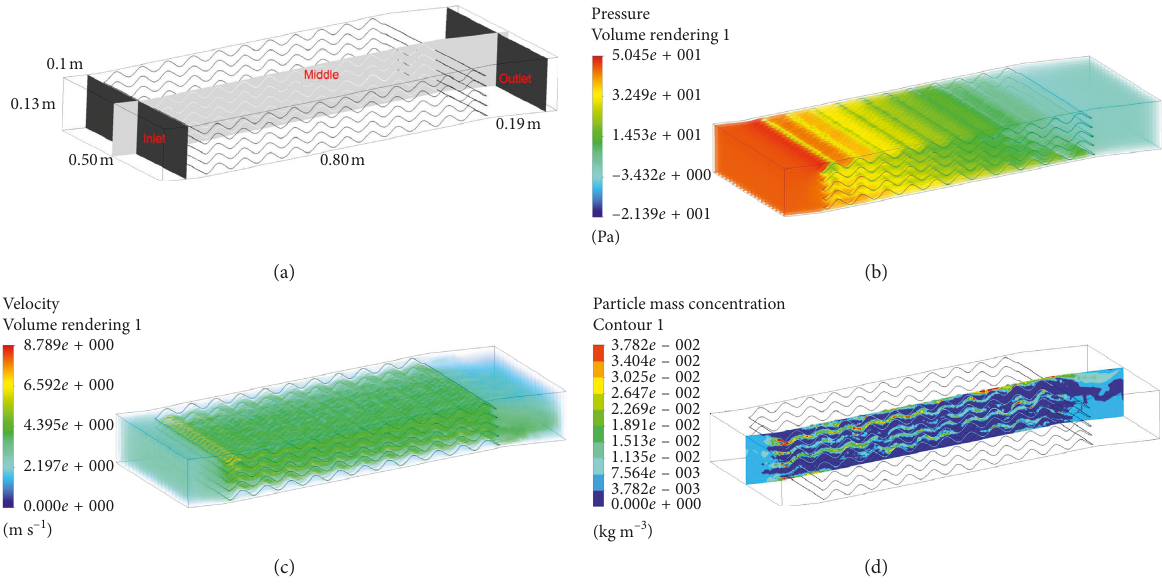
Figure 1: Simulating graphs from ANSYS-Fluent. (a) Geometry. (b) Pressure. (c) Velocity. (d) Particle mass